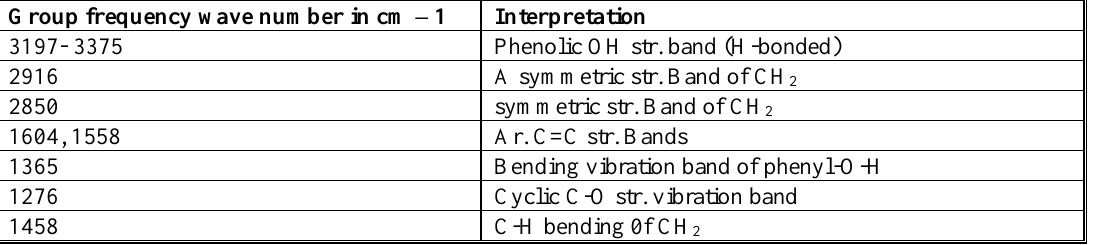
Table 6. FTIR Interpretation of Compounds II.